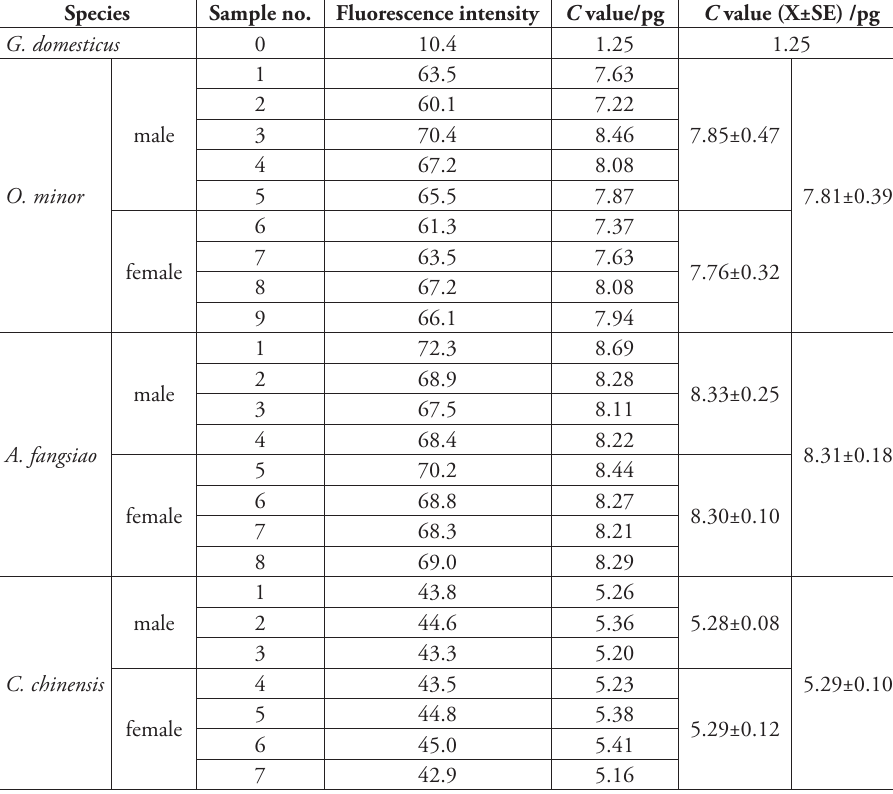
Table 2. The results of C values from three species of octopods. Species Sample no. Fluorescence intensity C